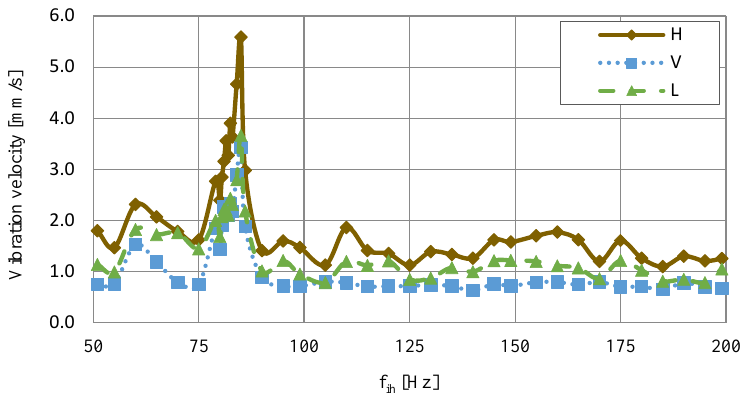
Figure 14. Measured broad-band vibration velocity in the horizontal (H), vertical (V) and longitudinal (L) direction vs. interharmonic frequency for motor 4-p4 coupled with the DC generator.